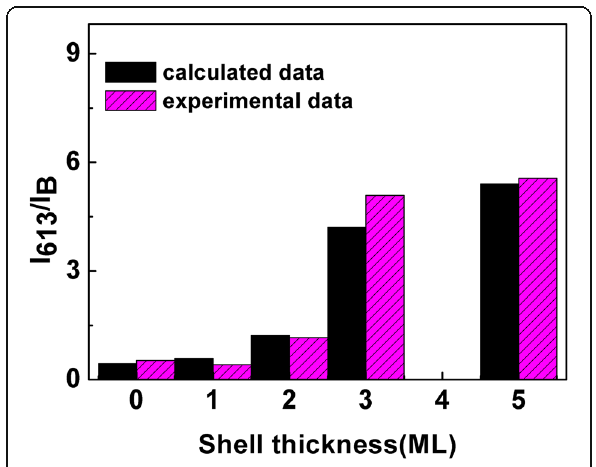
Fig. 6 Fitting diagram of experimental and theoretical values of τ (cid:4) and . The inset is PL ratio of ZnSe:Eu QDs to ZnSe:Eu/ZnS QDs τ 0 and fluorescence lifetime ratio of them with different shell thickness